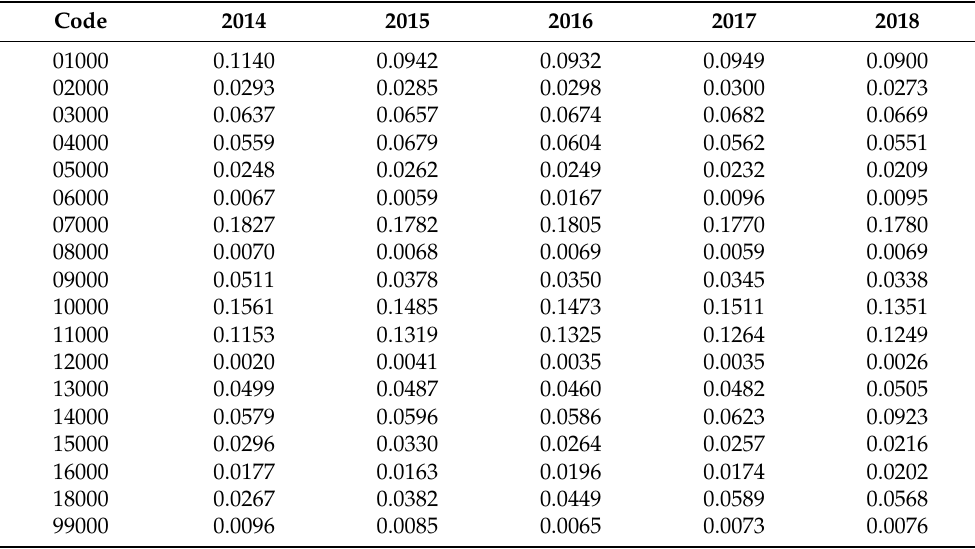
Table A2. The first step of fuzzification of the flags of the ships deficiency data in Tokyo